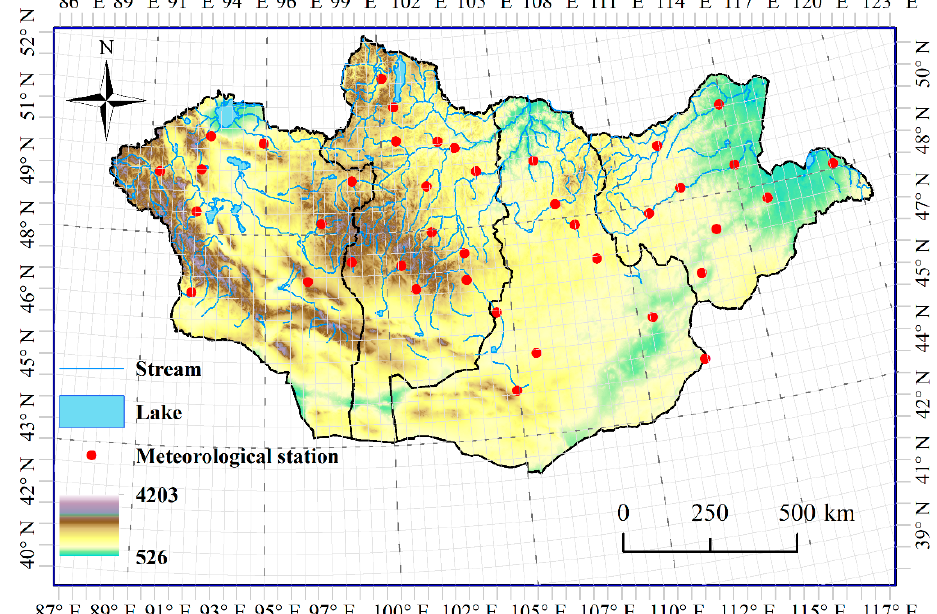
Figure 1. The grid of Gravity Recovery and Climate Experiment (GRACE) satellite in Mongolia, showing lakes, streams, meteorological stations, administrative boundaries, and elevation.